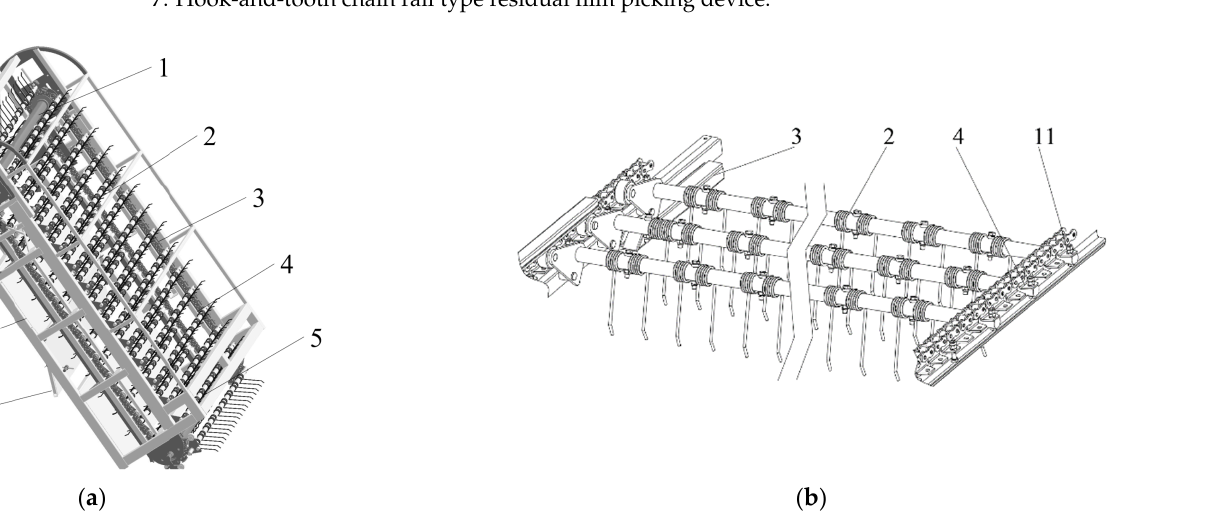
Figure 2. Hook ‐ and ‐ tooth chain rail type film picking device: 1. Chained rake frame upper shaft assembly; 2. Hook tooth assembly; 3. Guide beam; 4. Curved edge conveyor chain; 5. Chain rake frame lower shaft assembly; 6. Flap for discharging debris; 7. Chain rake frame; 8. Mounting plate; 9. De ‐ filming shaft; 10. Prevention of mulch sucking back parts; 11. Articulated short shaft. ( a ) the main components of the picking device, ( b ) Pick up film chain rake structure schematic diagram. Table 1. The main working parameters of a picking device.